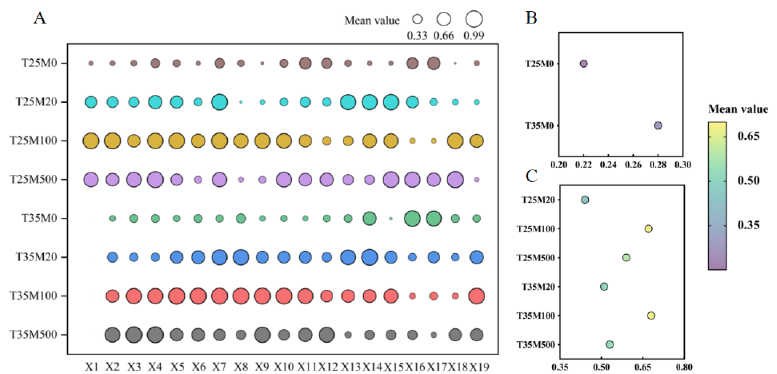
Figure 9. Comprehensive evaluation of rice seed tolerance under the drought stress and interac-tive treatment. ( A ) is the subordinate function value of each index under single and interactive treatment. ( B , C ) are the average subordinate function values of single drought stress treatment and interactive treatment, respectively. X1: Germination rate (7 d); X2: Germination rate (10 d); X3: Germination